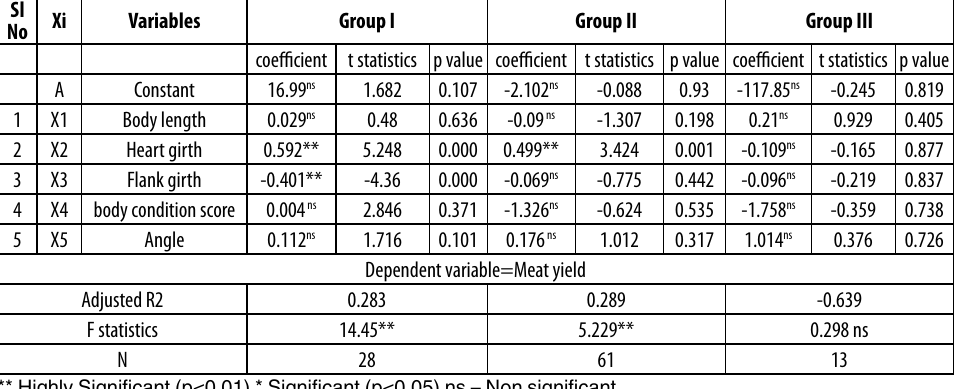
table 6. Regression analysis for developing prediction equation for total meat yield using live animal physical body measurements in three different weight groups